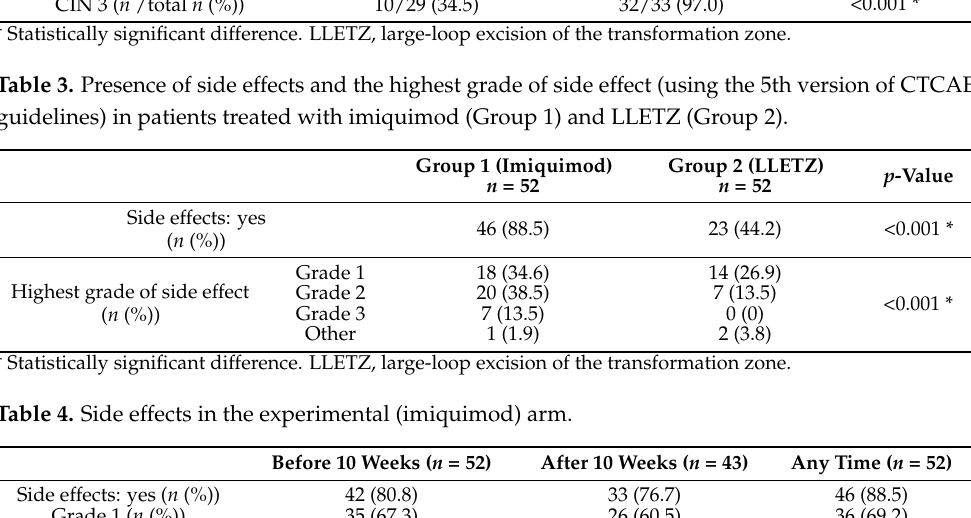
Table 2. Success of treatment in patients treated with imiquimod (Group 1) and LLETZ (Group 2). Group 1 (Imiquimod) p -Value All patients ( n /total n (%))